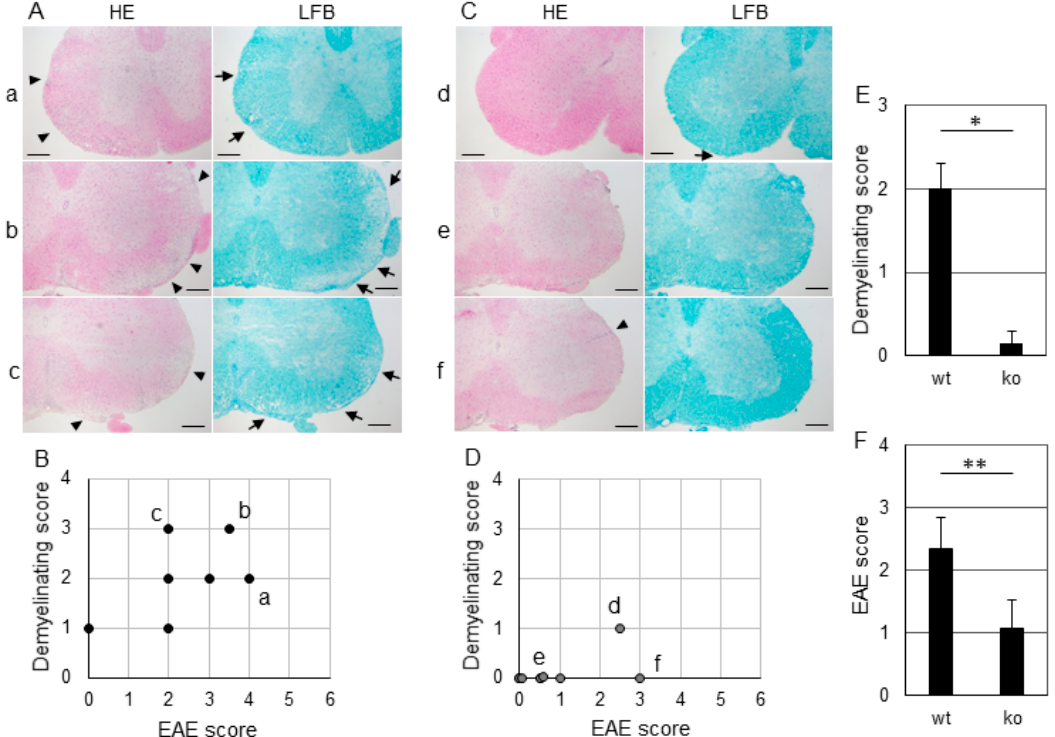
Figure 2. Histopathology of EAE mouse spinal cords at 19 days after immunization. Sections of lumbar spinal cord from wild-type (wt) experimental autoimmune encephalomyelitis (EAE) mice ( A ). Hematoxylin–eosin H–E staining showed massive infiltration of mononuclear cells into the parenchyma (left panel, arrowhead), and luxol fast blue (LFB) staining showed the diffuse demyelination (right panel, arrow) in wt EAE mice. Relationship between paralysis score and demyelinating score in wt EAE mice ( B ). Points a, b, and c in ( B ) corresponded to each panel in ( A ). Sections of lumbar spinal cord from microsomal PGE synthase-1 (mPGES-1)-deficient ( mPGES-1 − / − ) EAE mice ( C ). H–E staining showed that infiltration was localized to the intravascular or leptomeningeal space ( left panel, arrowhead), and LFB staining showed little demyelination ( right panel, arrow). Relationship between paralysis score and demyelinating score in mPGES-1 − / − EAE mice ( D ). Points d, e, and f in ( D ) corresponded to each panel in ( C ). Demyelinating score in wt EAE mice and mPGES-1 − / − EAE mice ( E ). Paralysis score in wt EAE mice and mPGES-1 − / − EAE mice ( F ). Scale bars, 200 µ m (for all images); wt, wild-type; ko, mPGES-1 − / − ; H–E, hematoxylin–eosin, LFB, luxol fast blue. * p < 0.001, ** p < 0.05.